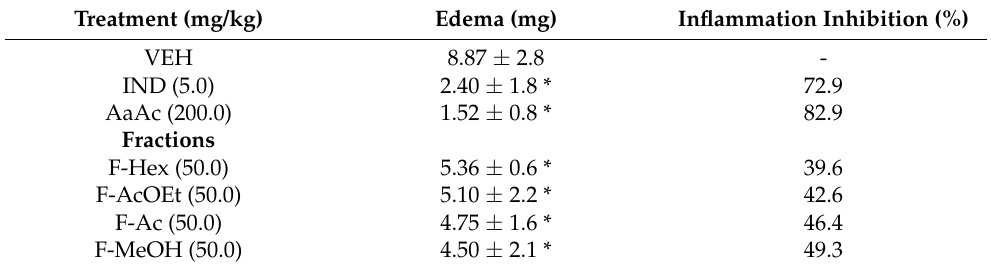
Table 1. Effect of the extract and fractions from A. angustifolia on xylene-induced ear edema in mice. Treatment (mg/kg)